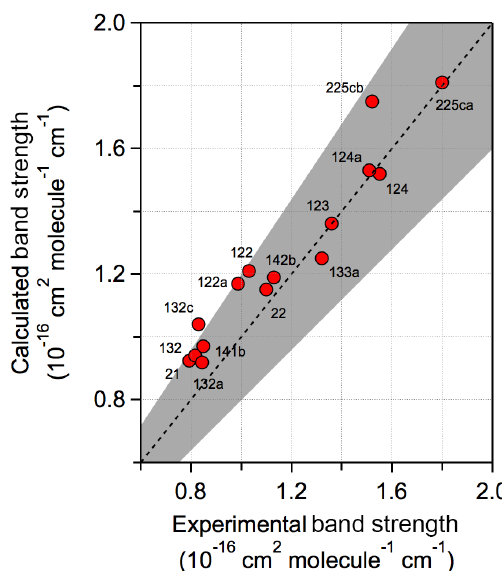
Figure 4. Comparison of experimental and calculated infrared band strengths over the 500–2000cm − 1 region for the HCFC training dataset (see Table 1 for the source of the experimental spectra). The dashed line is the 1 : 1 correlation. The shaded region represents a 20% spread around the 1 : 1